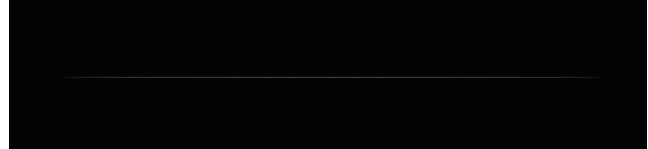
Figure 10: Illumination distribution on the position of Z = 500 km.